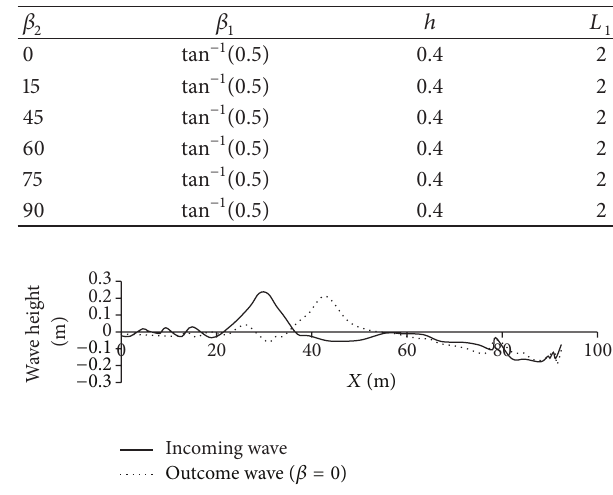
Table 3: Breakwater’s characteristics.